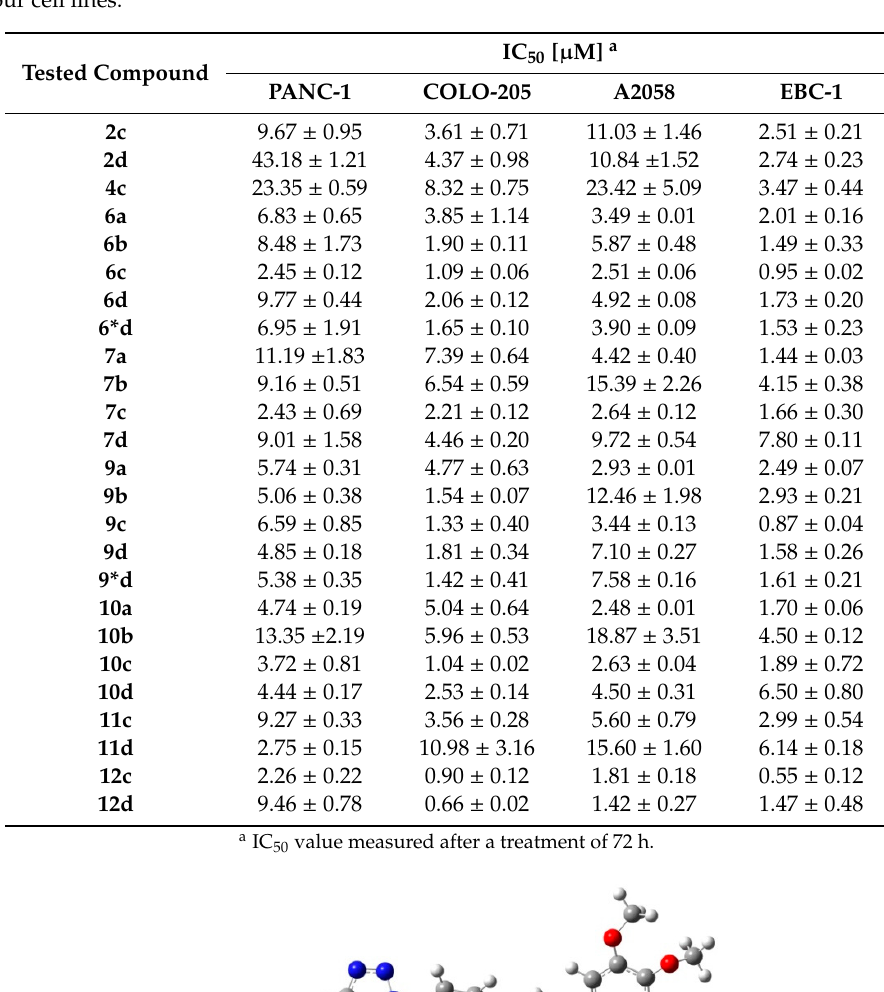
Figure 3. Effects of 10b and 12c on the cell cycle progression of PANC-1 cells. The model cell was treated with the compounds at their IC 50 concentration for 24 h. Results are expressed as a percentage of cells in the subG1 phase (( A )— 10b and ( D )— 12c ) and the major phases (G1/G0, S and G2/M) of the cell cycle (( C )— 10b and ( D) — 12c ). Data shown in the figure represent mathematical averages of two parallel measurements.